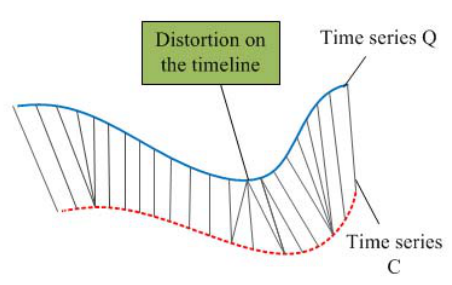
Figure 3. Distance measurement method dynamic time warping (DTW).